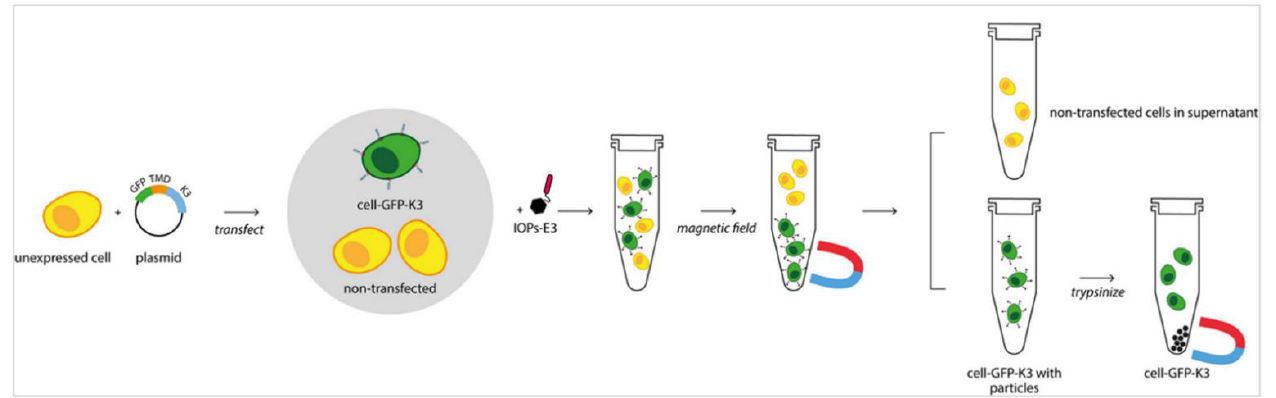
Figure 7. Specific isolation of cells transfected with a plasmid encoding the K3 coiled-coil forming peptide. Reprinted with permission from [133].